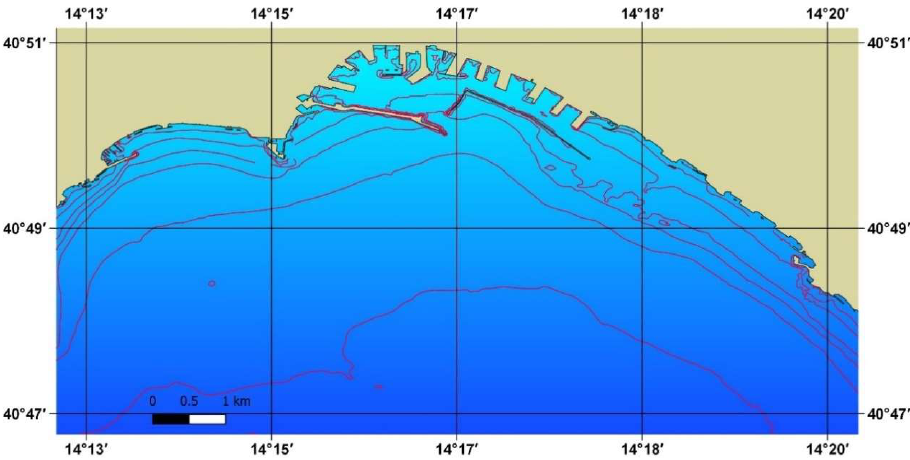
Figure 7. ENC n° 84 of the Port of Naples, produced in 2019 by IIMM: visualization in QGIS (only depth contours and coastline are highlighted).